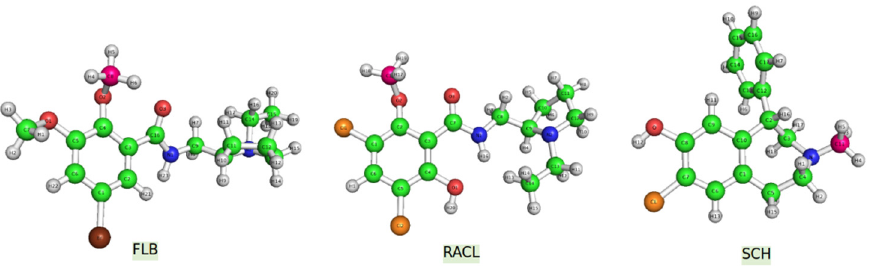
Figure 1. PCM (water)-B3LYP/6–311 + G (d,p) optimized molecular structures of the investigated ligands (the 11 C atoms are illustrated in pink).